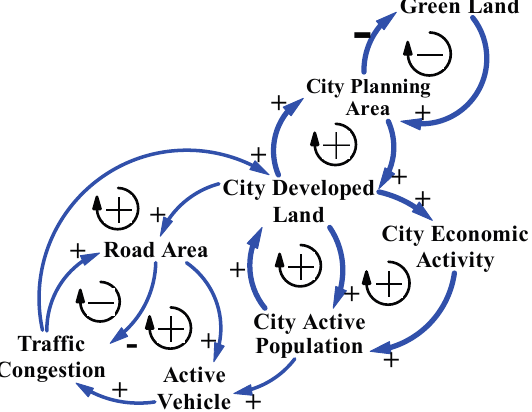
Figure 9. The positive and negative feedback loops of the CLD model in the context of economic growth for reasoning the relationships among land development, green land disappearance, and traffic